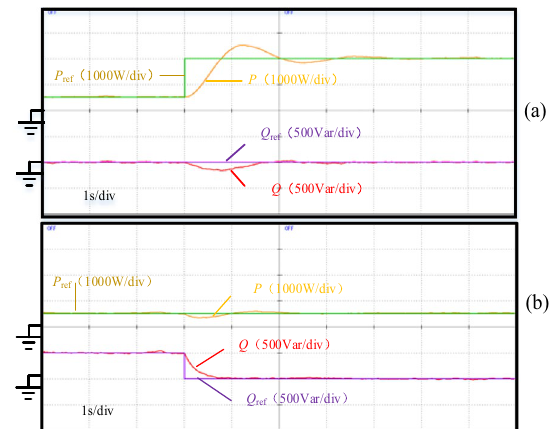
Fig. 7 Experimental waveforms of the power outer loop without compensation. a Active power P ref changes from 500 to 2000 W. b Reactive power Q ref changes from 500 to 0